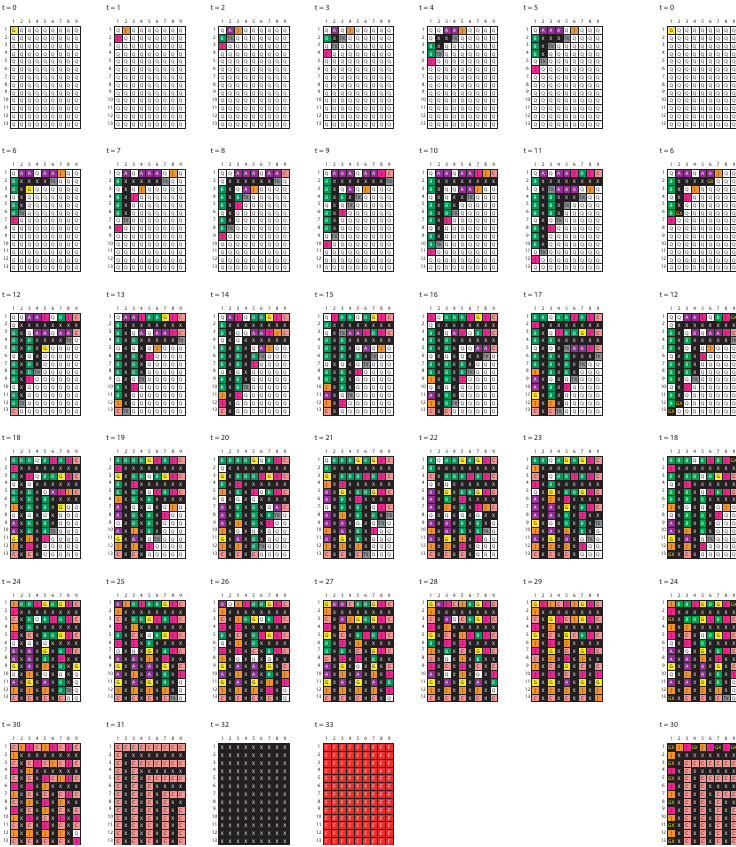
Fig. 4. Snapshots of the non-optimum-time ten-state synchroniza- tion process on a 13 × 9 rectangular array.